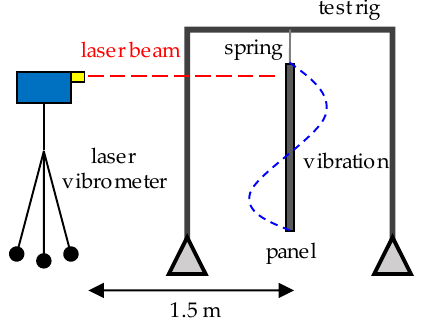
Figure 2. Experimental setup for laser vibrometry test: panel boundary conditions.